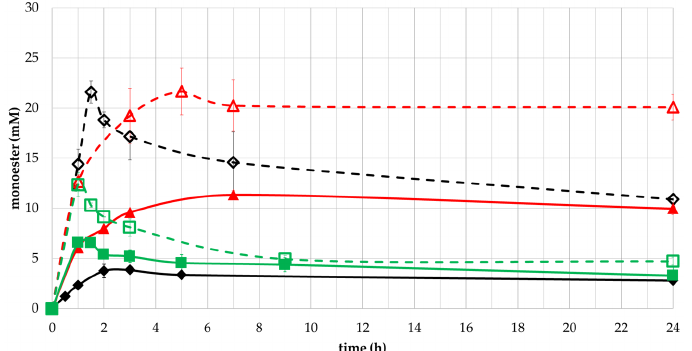
Figure 8. Time ‐ course of the monoester synthesis of lactulose by selected enzymes and effect of temperature in monoester production. Reaction conditions: 30 mM lactulose and 150 mM vinyl laurate, 25 mg/mL of biocatalyst, 2M2B (20% DMF). ― ― Novozym 435, 30 °C and ‐‐ ‐‐ 60 °C; ― ― Lipozyme from Mucor miehei , 30 °C and ‐ ‐ ‐ ‐ 60 °C, ― ― Lipozyme TL IM, 30 °C and ‐ ‐ ‐ ‐ 60 °C.